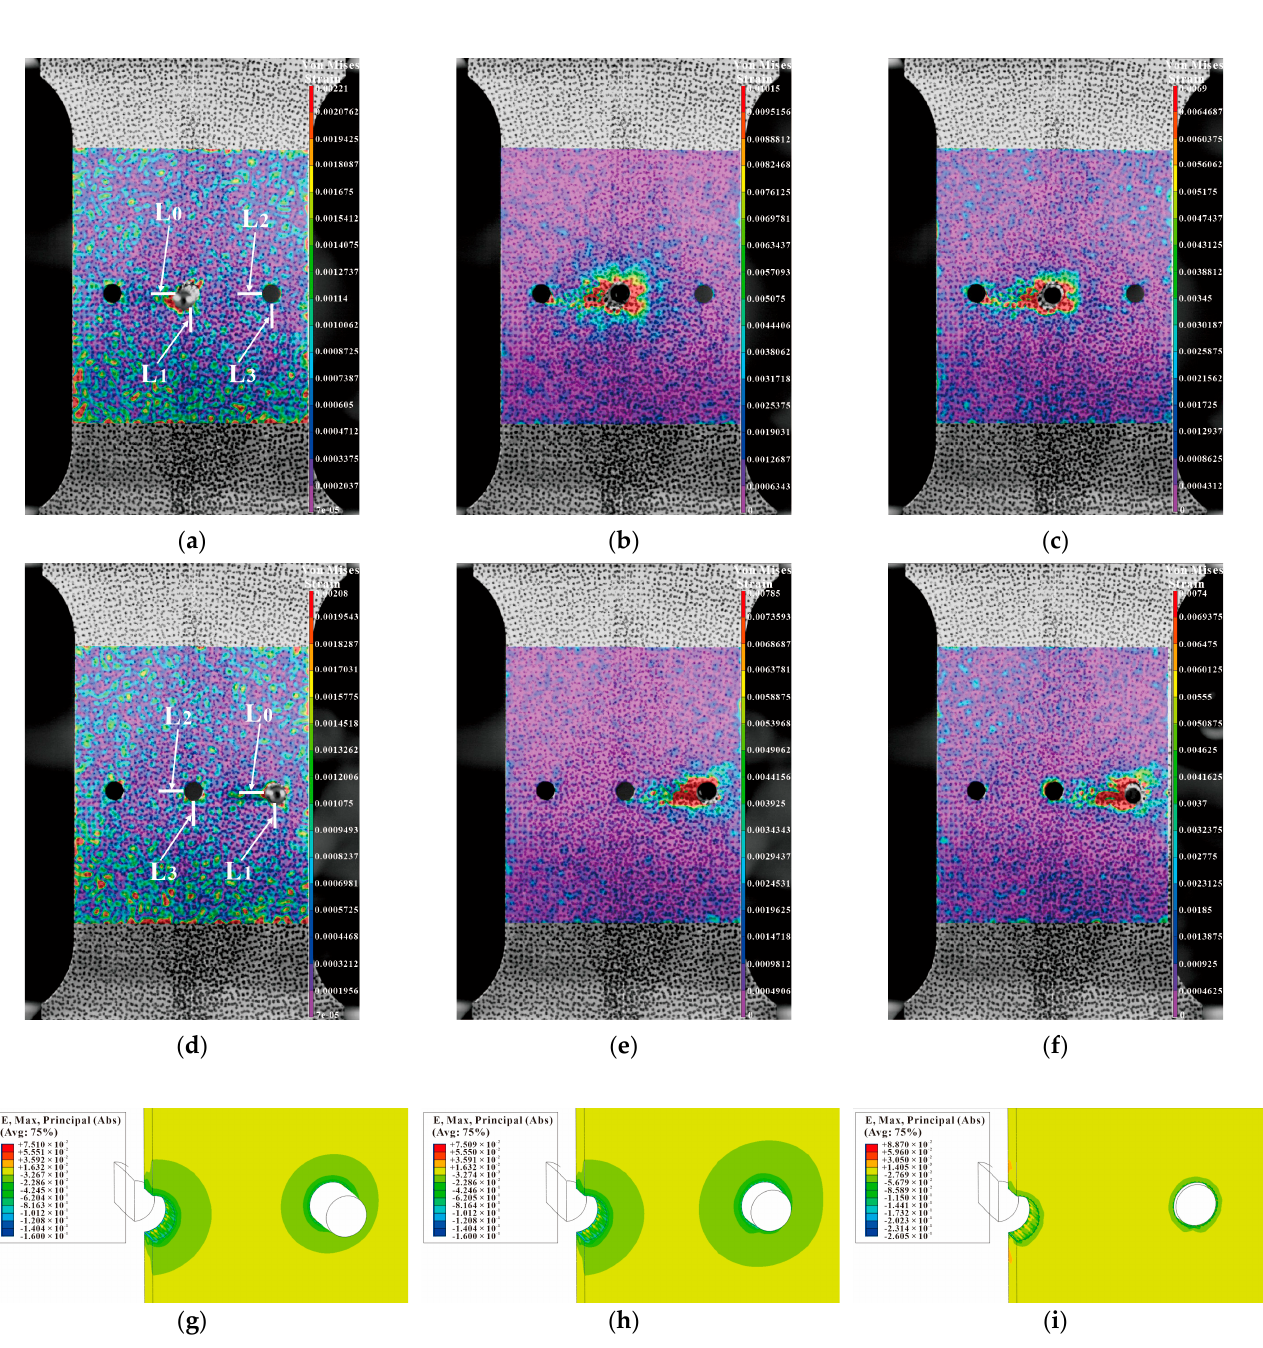
Figure 26. Comparison between DIC strain detection and FEM-predicted strain of three-hole speci- men with four times the hole diameter as hole spacing (sequential extrusion): ( a – c ) strain distributions before, during, and after SSCE of the middle hole; ( d – f ) strain distributions before, during, and after SSCE of the right hole; ( g – i ) the right-hole SSCE strain distribution of FEM. For the three-hole test piece, the test piece is completely symmetrical, therefore, only the von Mises strain at the hole edge of the middle and the right hole is analyzed. The DIC shot results are processed by Vic-2D and the strain variation on the four straight lines L 0 , L 1 , L 2 , and L 3 are selected from Figures 24a,d, 25a,d and 26a,d. The strain variation trend around each hole of the specimen is analyzed. Figure 27a–c show that the left side of the center hole during the initial SSCE of the middle hole produces the highest strain which is followed by the lower side of the center hole. At the same time, the strains on the left side and the lower end of the right side of the hole change during the SSCE of the center